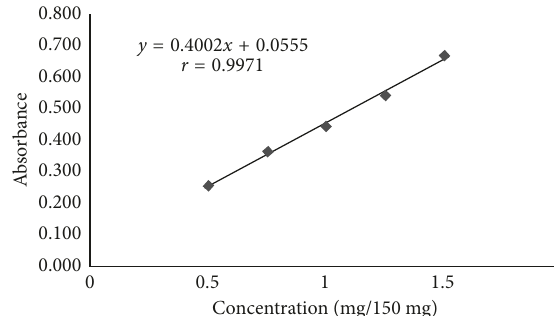
Figure 3: Graphical representation of the amoxicillin analytical curve by FT-IR